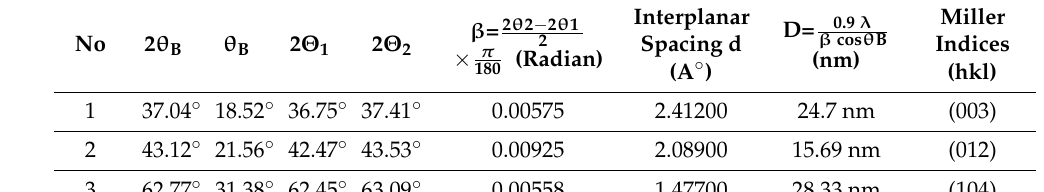
Figure 2. Spectroscopic analysis of BPL-NiONPs: ( a ) UV-Visible spectroscopy; ( b ) FTIR analysis; ( c )